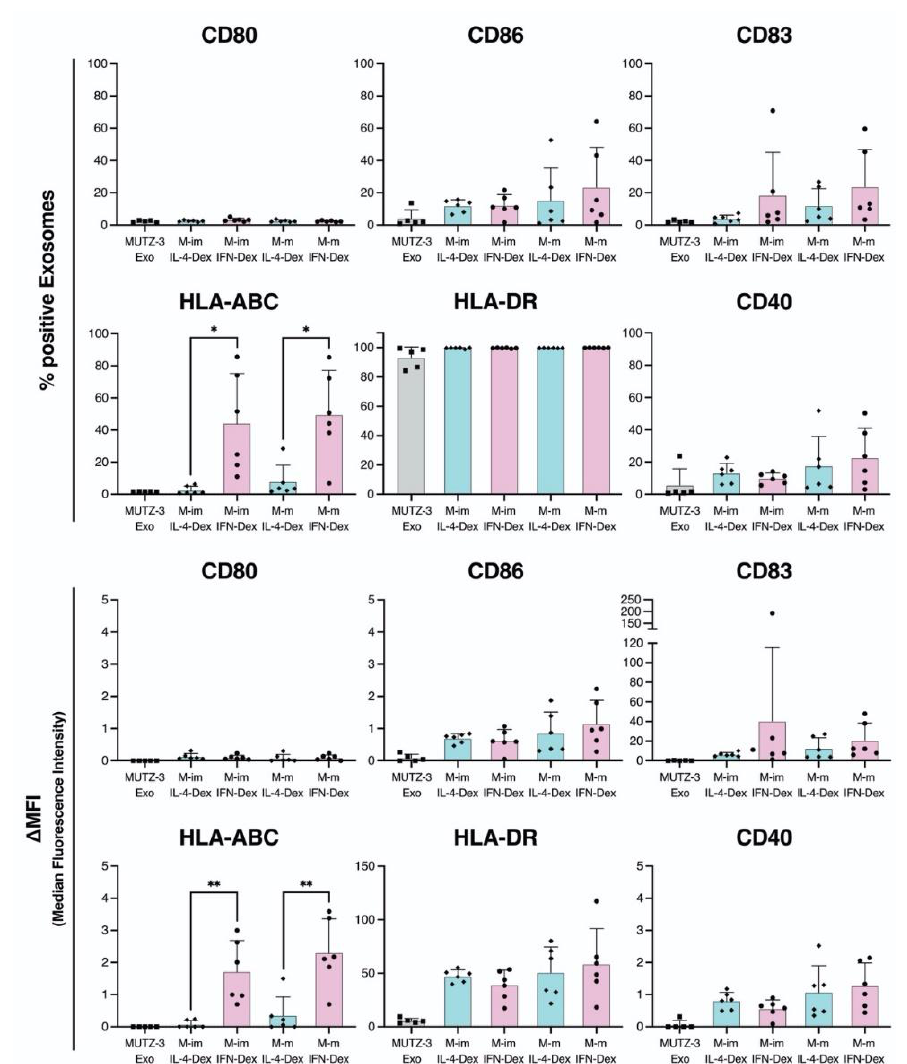
Figure 5. Comparison of immature and mature MUTZ-3-derived IL-4- and IFN-DC dexosome phenotypes. The DC maturation markers are shown as a percentage of positive exosomes and ∆ MFI. The ∆ median fluorescence intensity ( ∆ MFI) was calculated by subtracting isotype control MFI values from observed values. * p < 0.05 and ** p < 0.01 indicate statistically significant differences ( n = 6). The bars indicate the mean ± S.D. of independent experiments. The rhombus in the Scatter plot is MUTZ-3 derived IL-4-DCs. Circle is MUTZ-3 derived IFN-DCs. Square is MUTZ-3